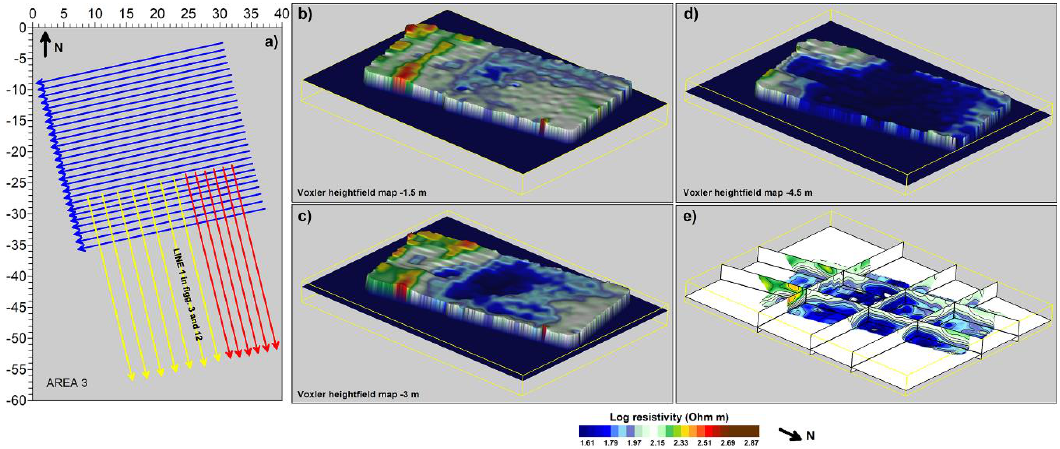
Figure 11. Modelled electrical resistivity map relative to 3.5 m in depth in relation to the features detected at 1 m in depth (indicated with yellow color).